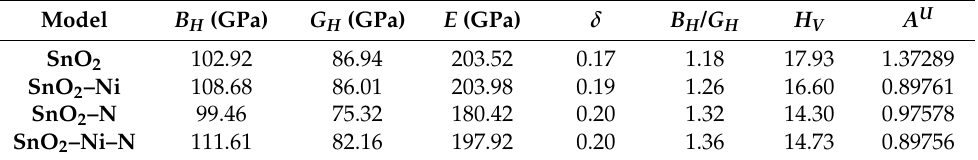
Table 4. Bulk modulus ( B H ), shear modulus ( G H ), Young's modulus( E ), Poisson's ratio( δ ), Hardness ( H V ), Bulk modulus to shear modulus ratio ( B H / G H ) and Universal elastic anisotropy Index ( A U ).